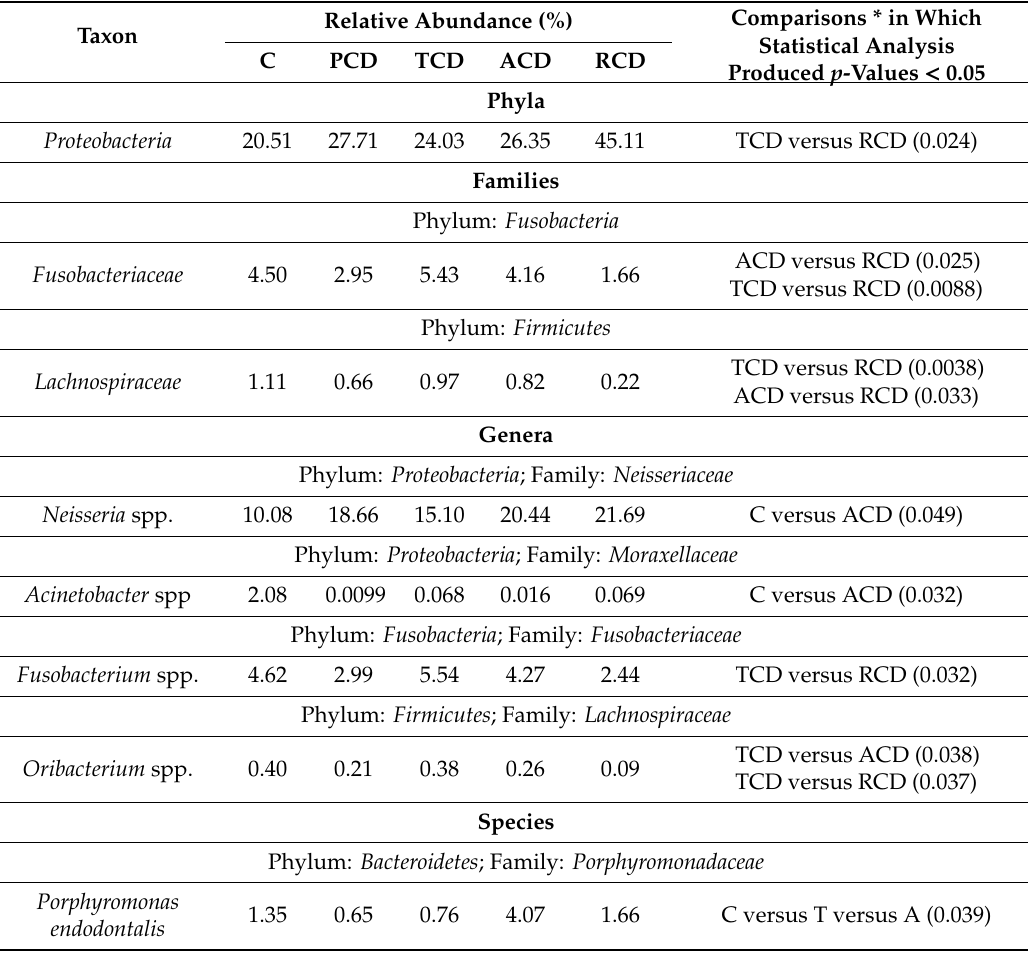
Table 4. Taxa displaying significantly di ff erent relative abundances in saliva samples. Relative Abundance (%) Comparisons * in Which Taxon 0.05C